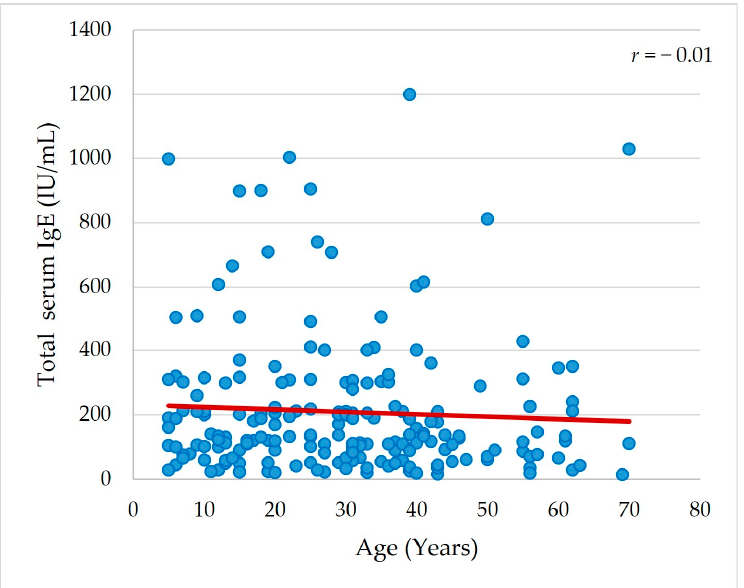
Figure 7. Correlation between age ( X axis) and total IgE serum level (IU/mL) ( Y axis) in the studied patients. Correlation was measured by Spearman’s rank correlation coefficient ( r ) (N = 200).